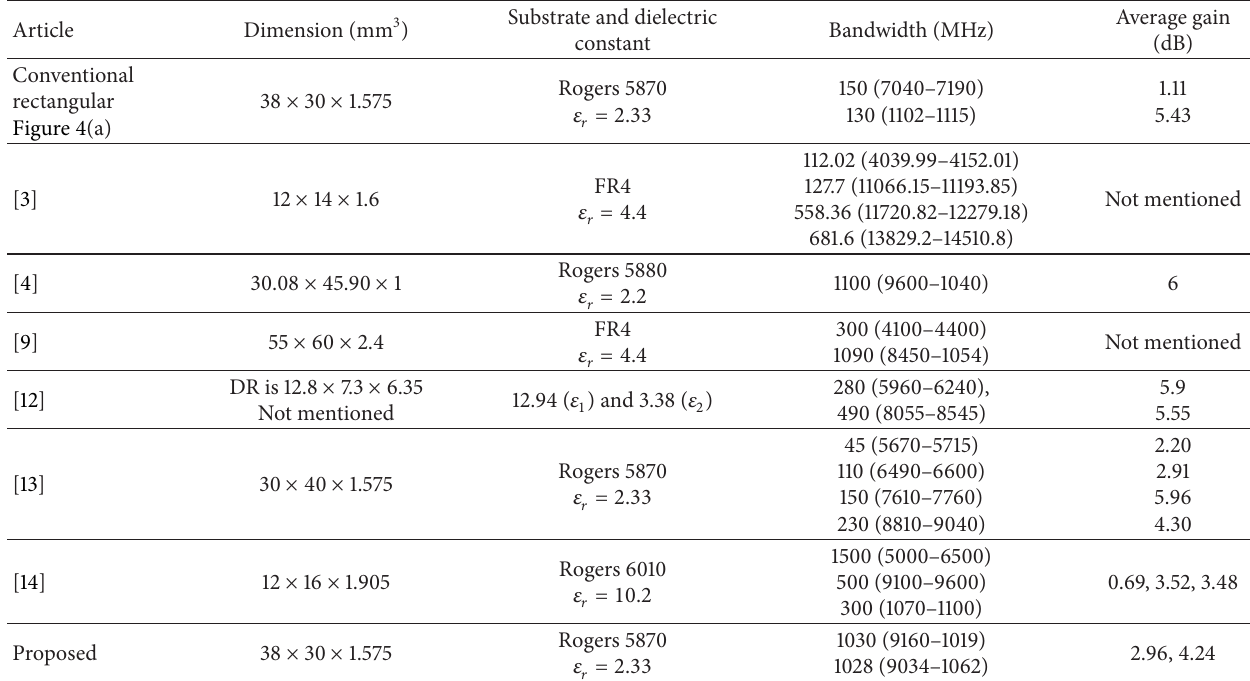
Figure 16: Photograph of the fabricated prototype: (a) front view; (b) back view; (c) simulated and measured reflection coefficients of the optimized antenna. Table 2: Comparison between other existing